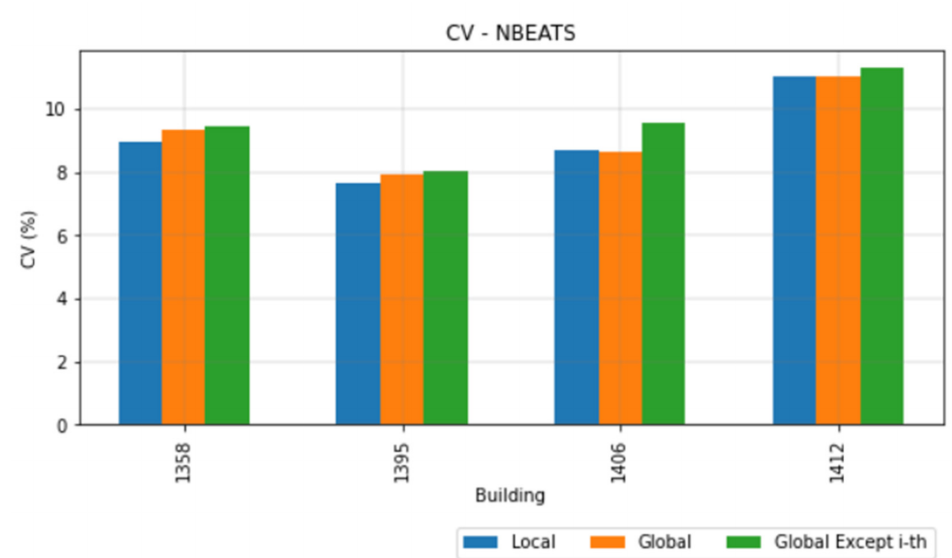
Figure 22. Comparison between the CV on test set obtained using NBEATS method with different modalities: local, global and global trained using all the available data except the energy consumption related to the selected building.